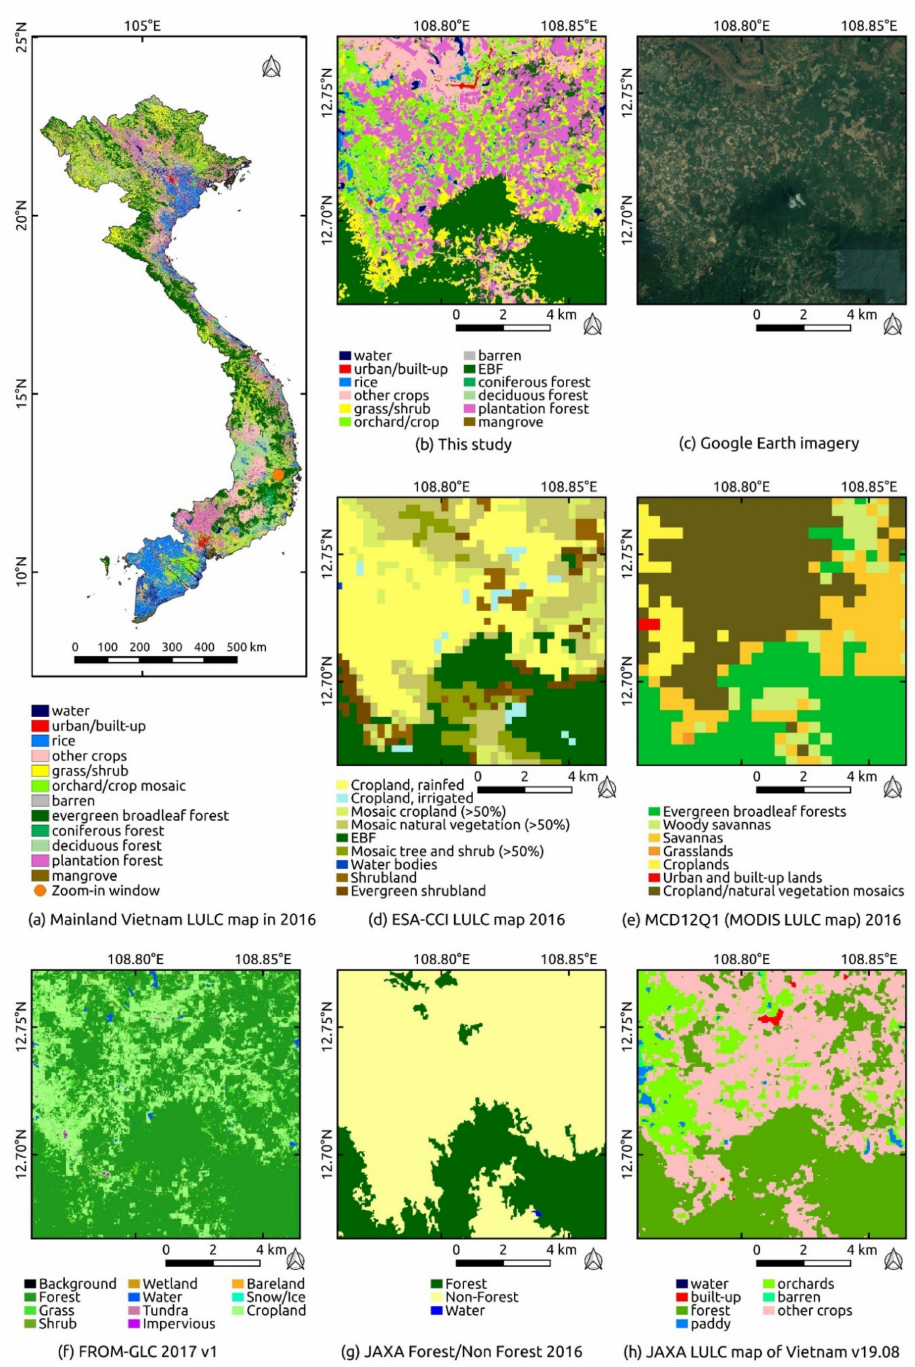
Figure 6. The resultant Vietnam LULC map 2016 and its comparison to other LULC products. ( a ) The overall mainland Vietnam LULC map in 2016; ( b ) The LULC map of this study in the zoom-in window; ( c ) The Google Earth imagery in the zoom-in window; ( d ) ESA-CCI LULC map 2016 in the zoom-in window; ( e ) MCD12Q1 (MODIS LULC map) 2016 in the zoom-in window; ( f ) FROM-GLC 2017 v1 LULC map in the zoom-in window; ( g ) JAXA Forest / Non Forest map 2016 in the zoom-in window; ( h ) JAXA LULC map of Vietnam 2016 (version 19.08) in the zoom-in